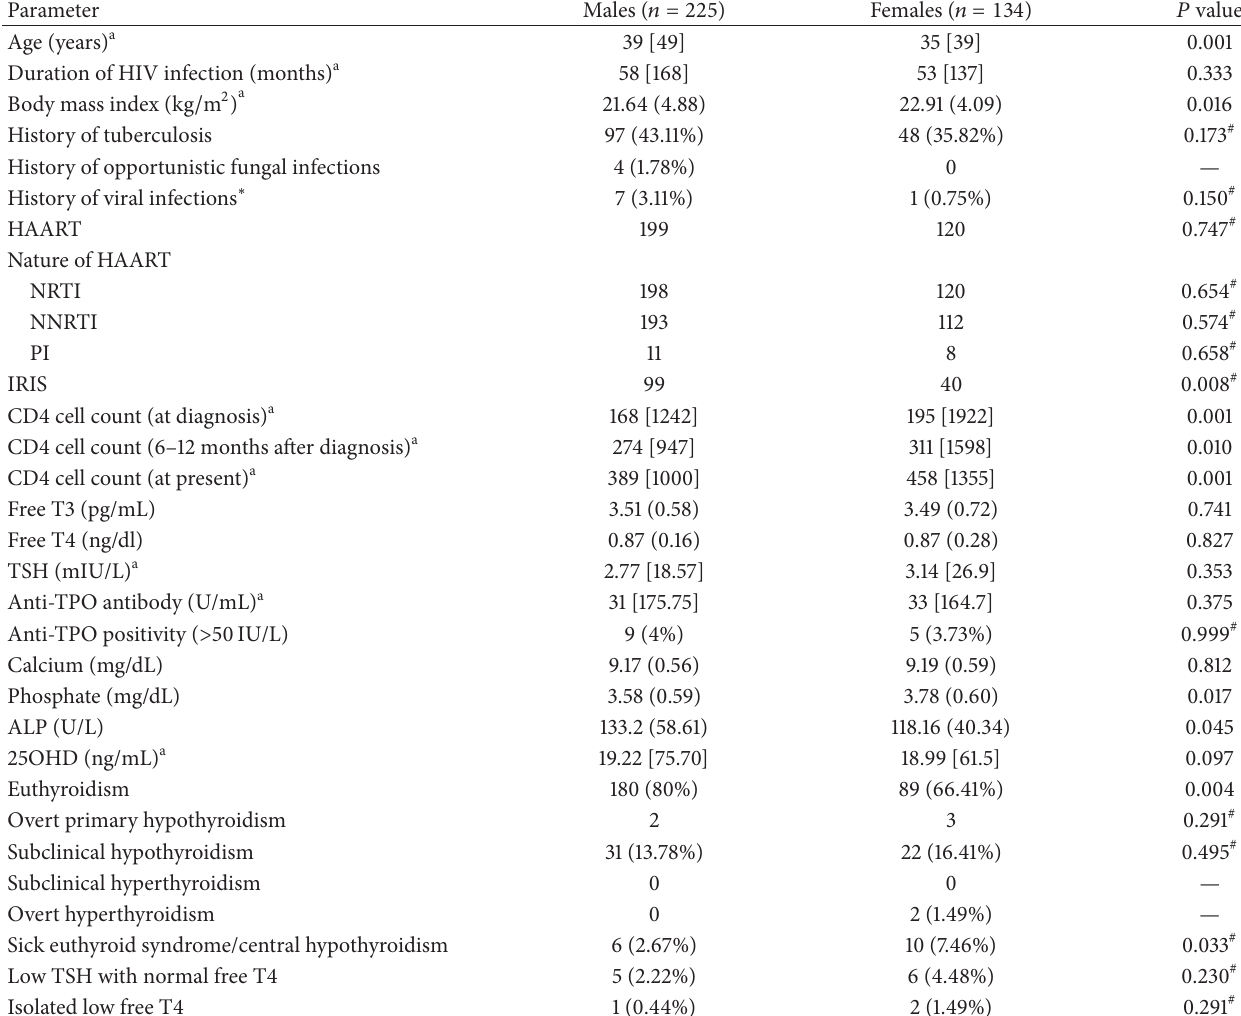
Table 1: Clinical, biochemical, and thyroid function profile of males as compared to females with HIV infection.